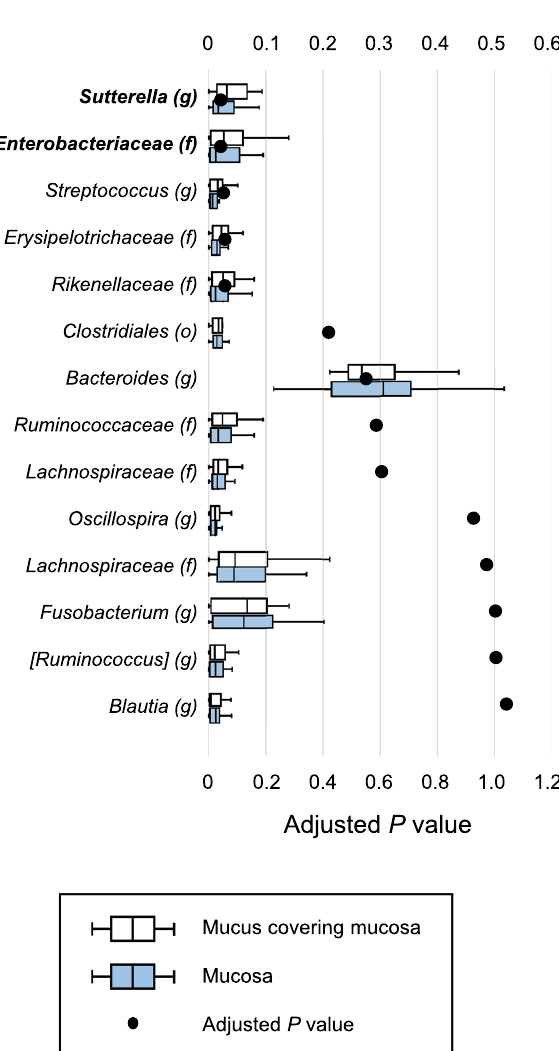
Figure 2. Comparisons of relative abundance in the mucus covering the mucosa and the mucosa after washing at up to the genus level by boxplot. Whiskers are extended to the most extreme data point, which is no greater than 1.5 × the interquartile range from the edge of the box in the boxplot. Statistical significance was determined using the Wilcoxon signed-rank test. The Benjamini–Hochberg method for controlling the false-discovery rate was used for multiple